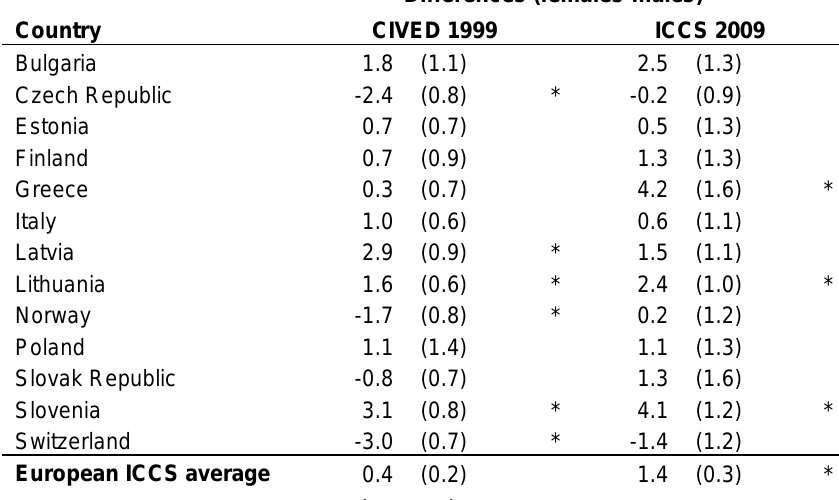
Gender differences in civic content knowledge in